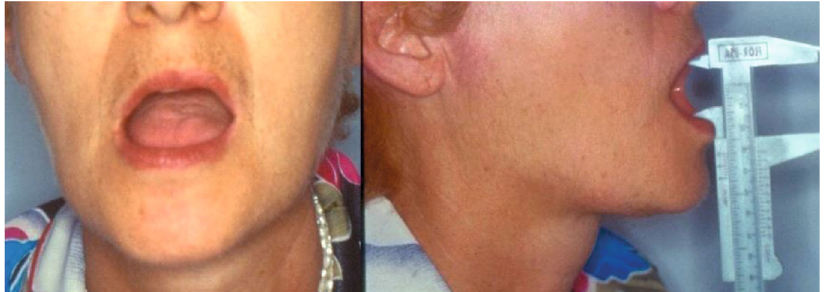
Figure 2: Limited open mouth measured by means of a mechanical calliper. Presence of laterodeviation towards the right side.